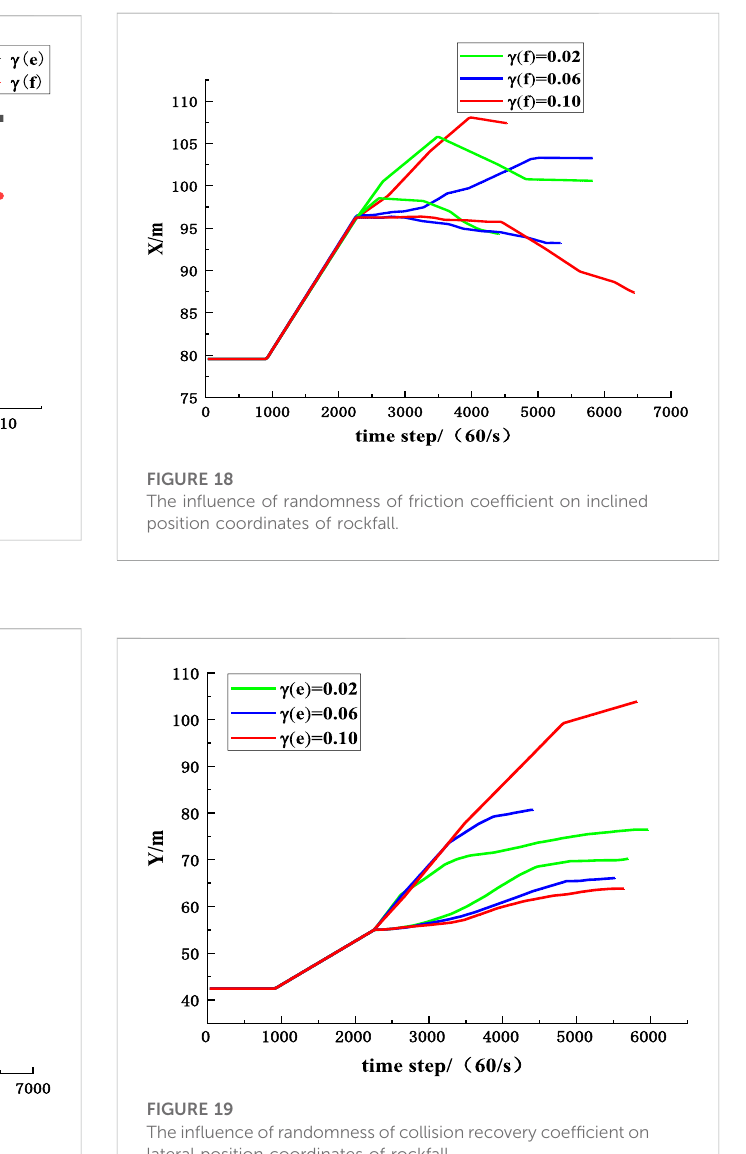
FIGURE 17 The in fl uence of randomness of collision recovery coef fi cient on inclined position coordinates of rockfall.